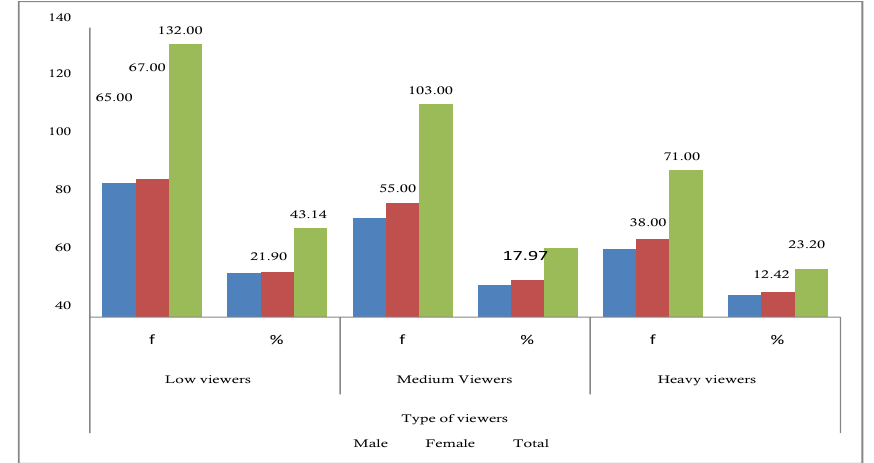
Figure 1. Frequency and Percentage of TV